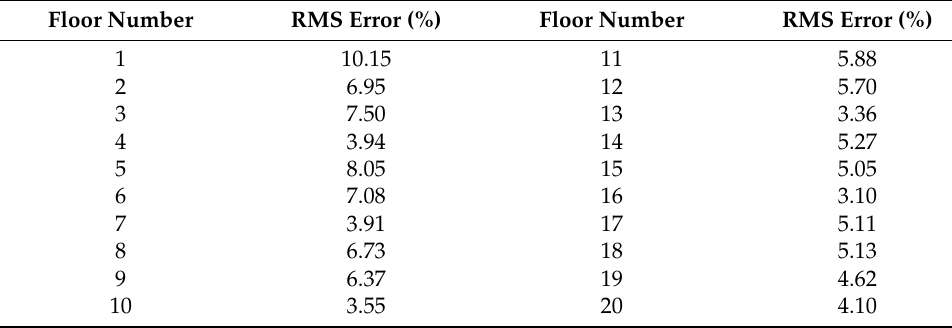
Figure 6. Comparison of time-varying wind loads at the ( a ) 1st floor, ( b ) 6th floor, ( c ) 12th floor and ( d ) 20th floor. Table 2. RMS error of the identified wind loads on the discrete frame